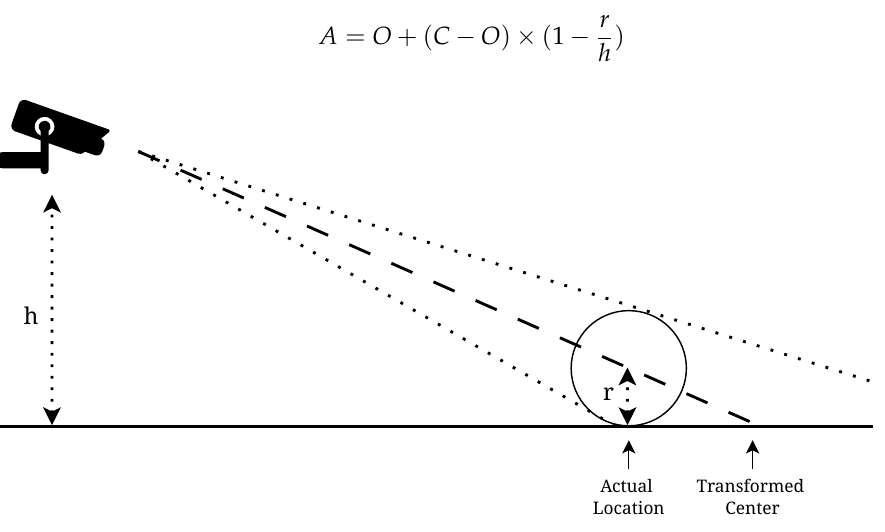
Figure 6. Illustration of locating